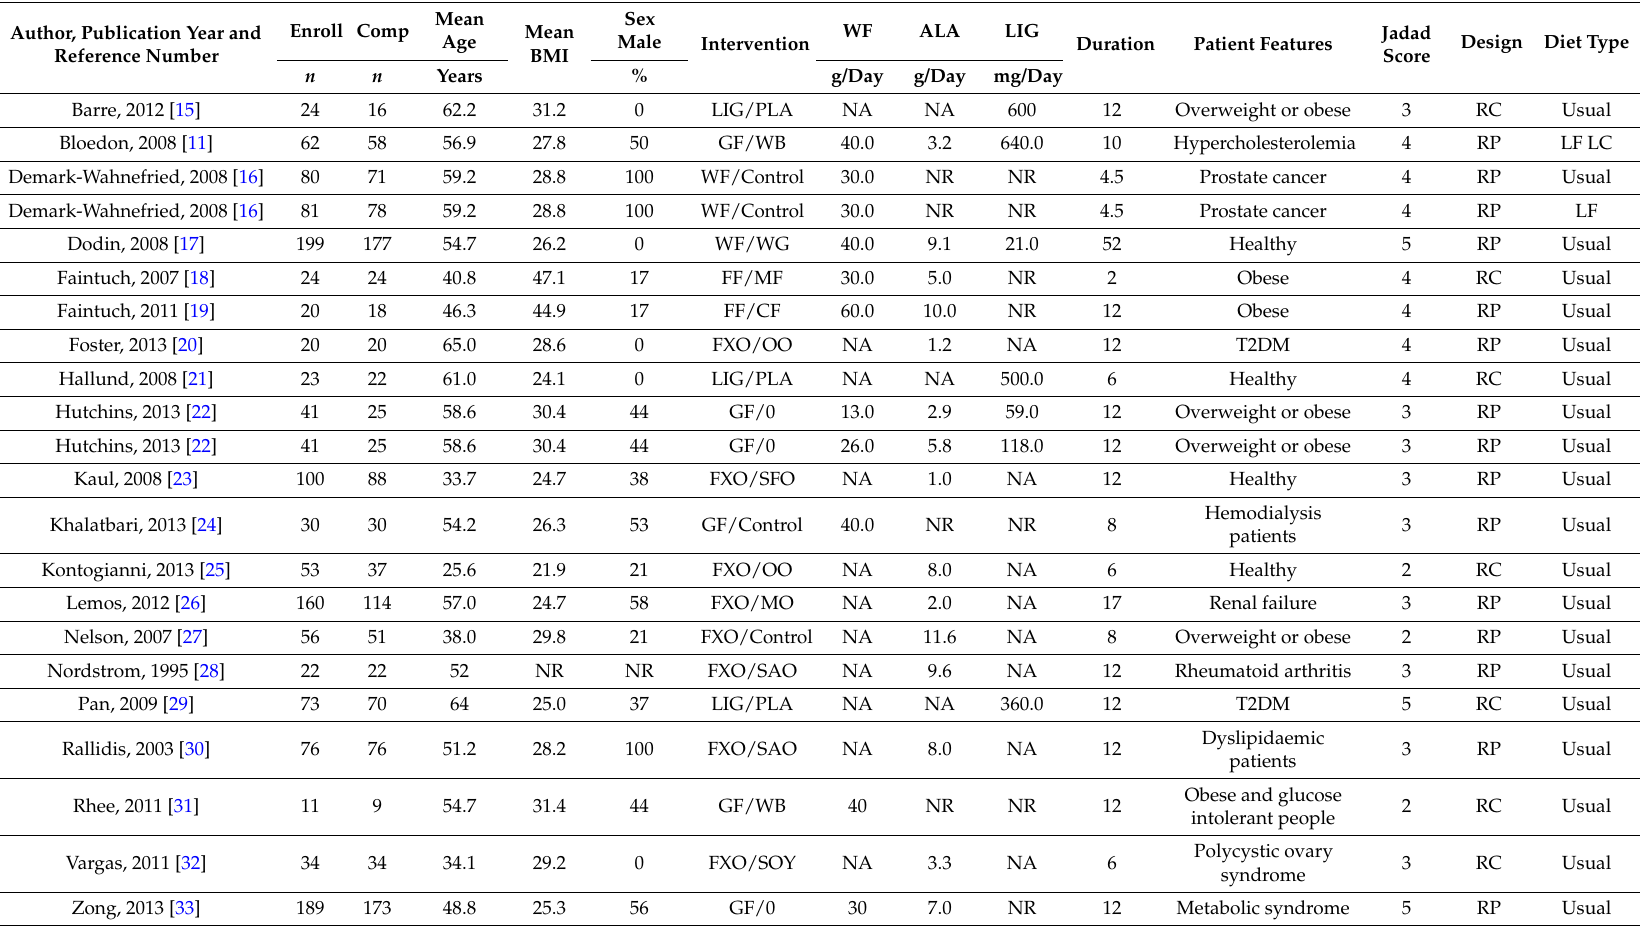
Table 1. Characteristics of the 20 included studies, with 22